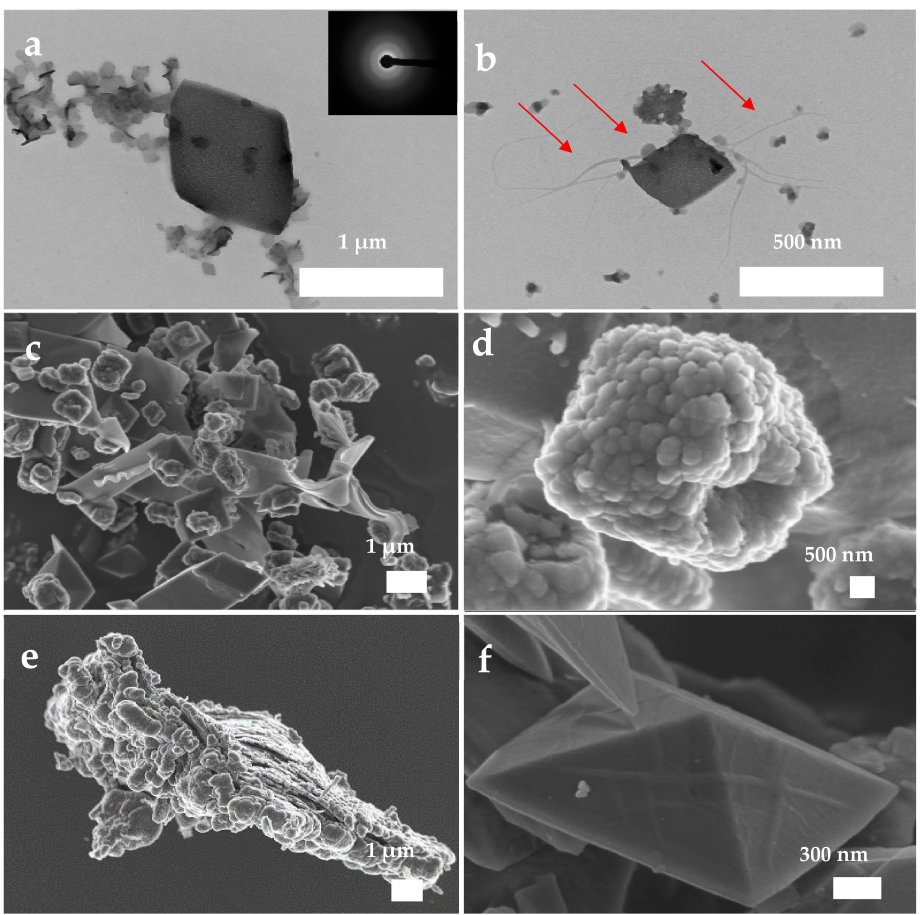
Figure 8. CaOx precipitates obtained during the post-nucleation stage in the presence of PAA. ( a , b ) TEM image and SAED study of ACO nanoparticles, ( c – f ) FESEM images of different nanoparti- cles and crystals. Red arrows indicate interactions between rhomboid crystal, droplets and filaments in ( b